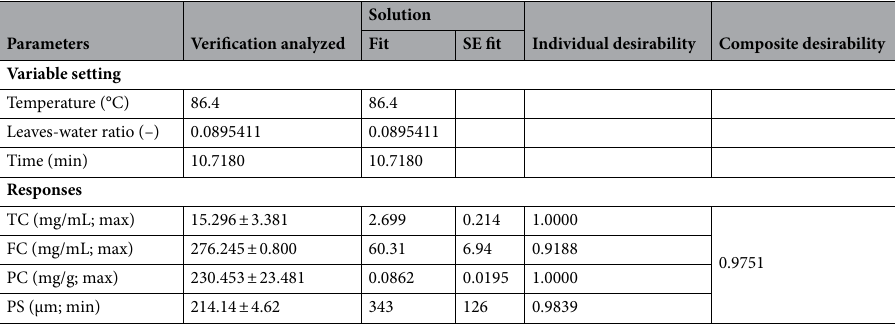
Table 5. Solution of multiple response prediction. SE Standard error, TC Total catechin content, FC Caffeine content, PC Total phenolic content, PS Powder particle size.